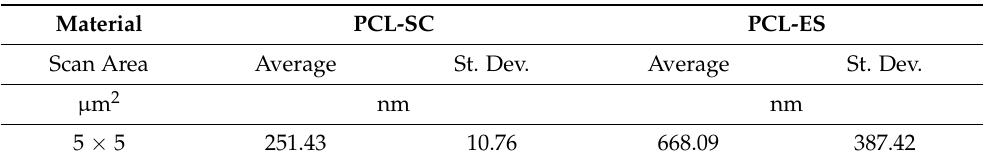
Figure 3. Topographical AFM analysis and 3D patterns of scaffolds: ( A ) Roughness of PCL solvent casting scaffold on 5 × 5 scan area; ( B ) 3D pattern of PCL solvent casting scaffold on 5 × 5 scan area; ( C ) Roughness of PCL electrospun scaffold on 5 × 5 scan area; ( D ) 3D pattern of PCL electrospun scaffold on 5 × 5 scan area. Table 3. Roughness of PCL-SC and PCL-ES scaffolds on 5 μ m × 5 μ m and 20 μ m × 20 μ m scanning area.